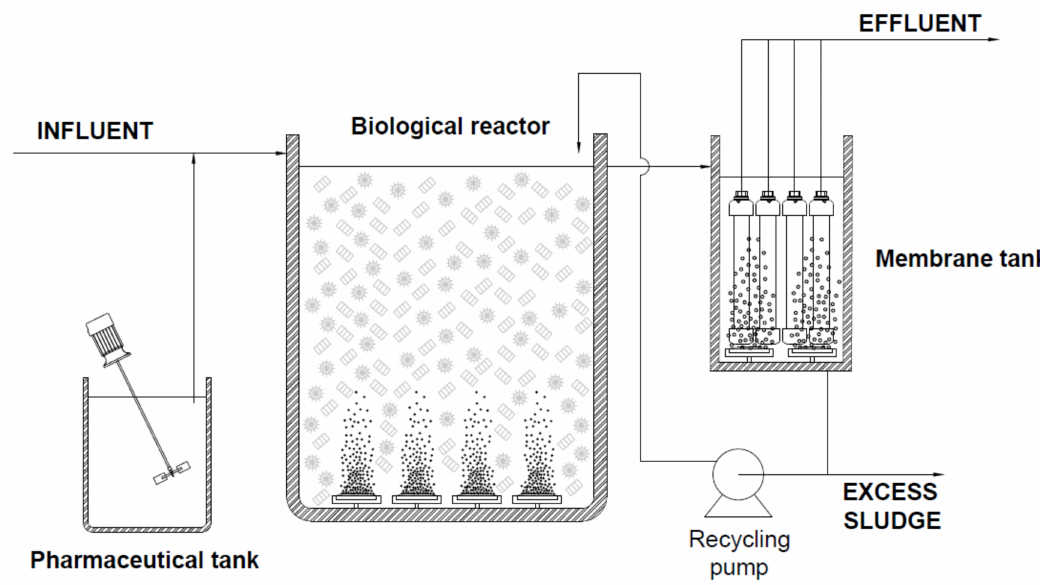
Figure 1. Schematic diagram of the pilot plant used in the research.